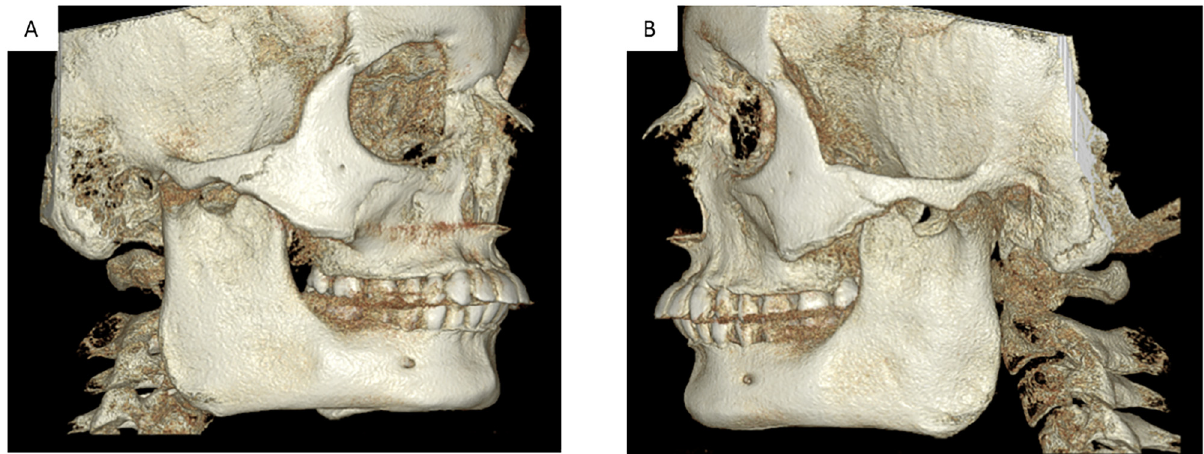
Fig. 3. 3D CBCT showed bilateral hypertrophy of mandibular